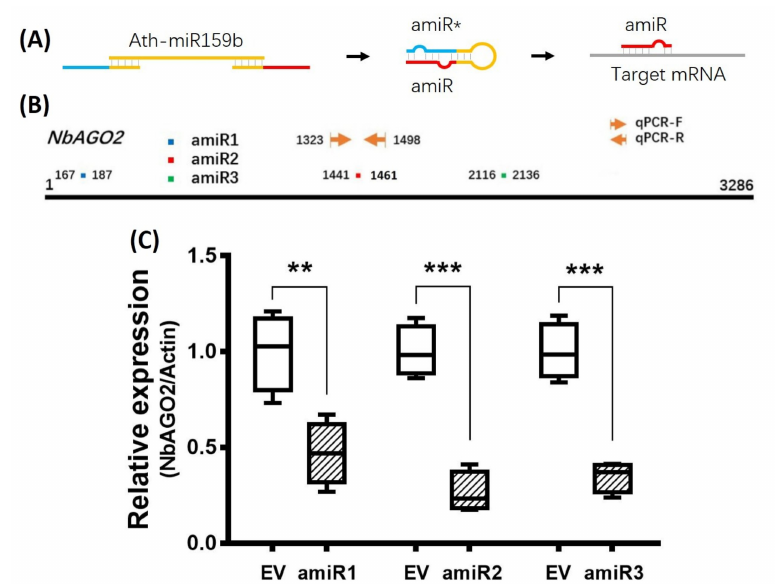
Figure 1. Silencing of NbAGO2 via transient expression of di ff erent amiRs from pCV-based vector. ( A ) Oligonucleotides for amiR was designed, and the sequences were used as primers to amplify Arabidopsis thaliana miR159b to produce amiR construct. After transcription and processing, mature amiR binds to complementary site at target mRNA. amiR* denotes amiR star strand. ( B ) The positions of amiR target sequences on NbAGO2 were shown with di ff erent colors, and qPCR primers for detection of NbAGO2 expression were shown with arrowhead. The numbers indicated the positions of amiR target sites and qPCR primers. ( C ) Di ff erent amiR constructs cloned in pCVA vector were transiently expressed in N. benthamiana leaves by agroinfiltration. At 3 DPI, plants were harvested and were assayed for NbAGO2 expression by quantitative real-time PCR. Plants inoculated with empty pCV vector (EV) served as control treatment, and NbAGO2 expression in control group was arbitrarily designated as 1. N. benthamiana NbActin gene served as the internal control. Significant di ff erences between control and treatment groups were calculated by Student’s t -test. Double and three asterisks indicated significant di ff erence at p < 0.01 and p < 0.001, respectively.